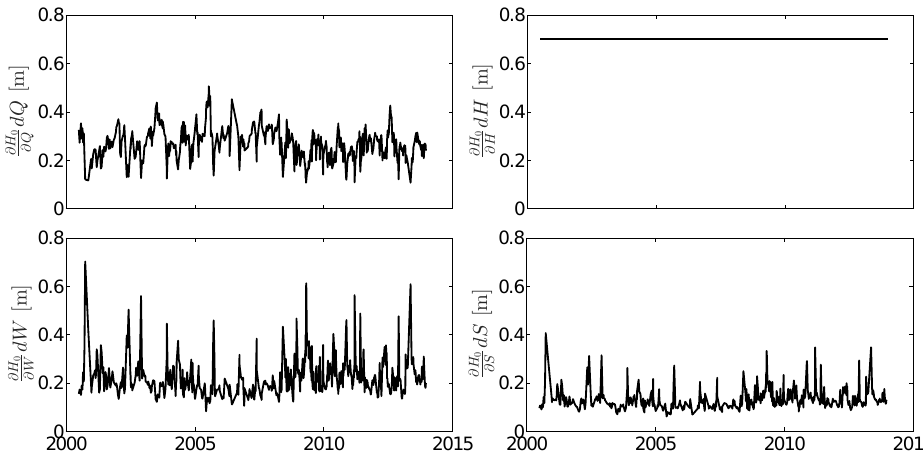
Figure 11. Time series of error in H 0 due to the error in Q , H , W and S for Model (1) over Reach 1.